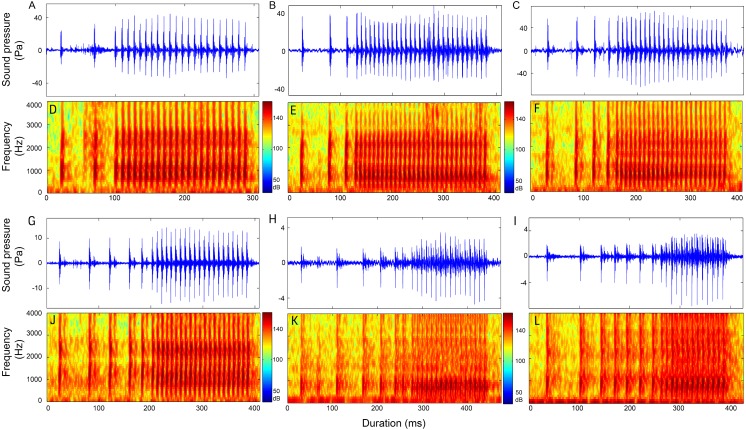
Reprsentative oscillogram and sonogram of the (A and D) (1 − )2 + N10, (B and E) (1 − )3 + N10, (C and F) (1 − )4 + N10 (G and J) (1 − )5 + N10, (H and K) (1 − )6 + N10, and (I and L) (1 − )7 + N10 call types.